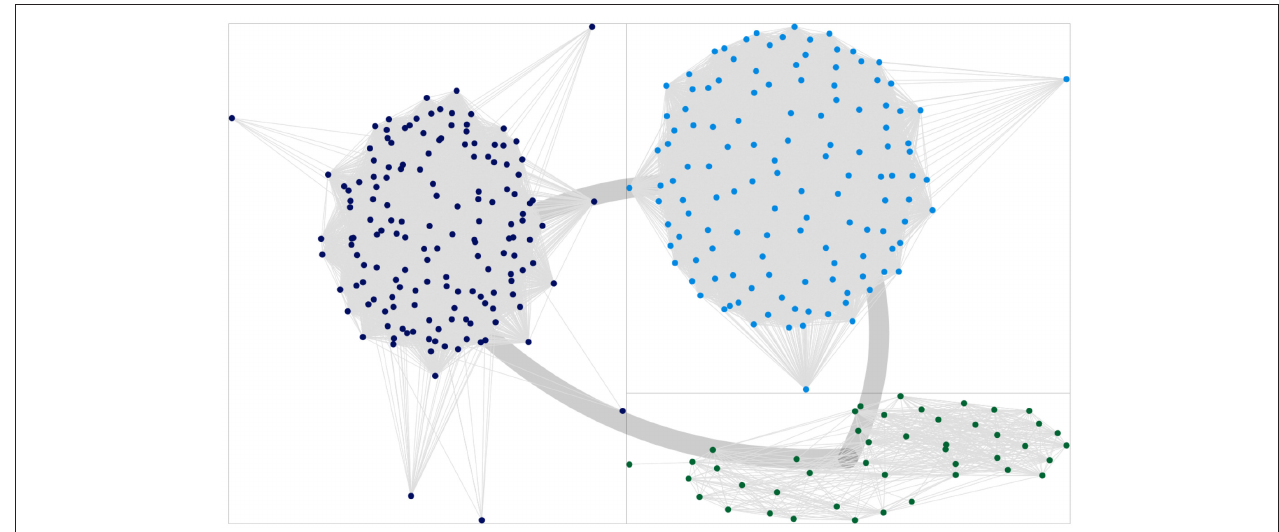
FIGURE 4 | Plot of the clusters obtained via the CNM algorithm, for the network reconstructed using the standard Jaccard method. Thick lines connecting the quadrants indicate the global cumulative strength of inter-community links. Dark blue dots indicate the community interpreted as “loyal to the Cabinet,” light blue dots are connected with the “opposition,” green dots are to be interpreted as “indipendent senators.”